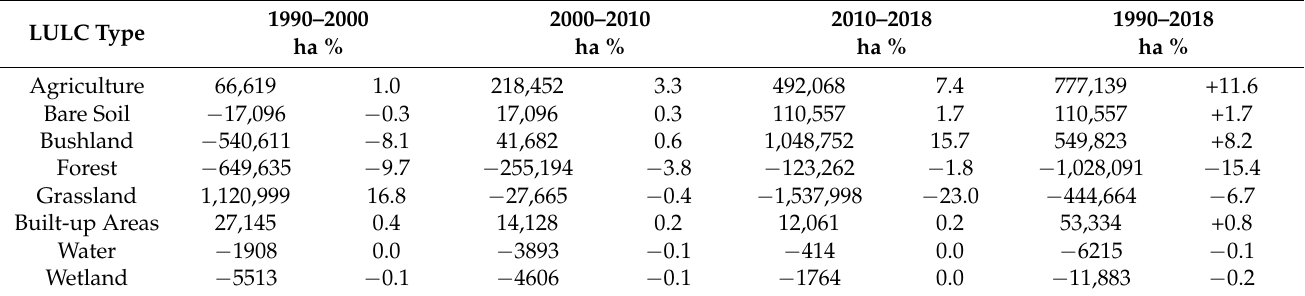
Table 7. The yearly interval results of the LULC classification images for 1990–2000, 2000–2010, 2010–2018, and 1990–2018, showing area change (+Gain and -Loss) in hectares (ha) and percentage (%) in the